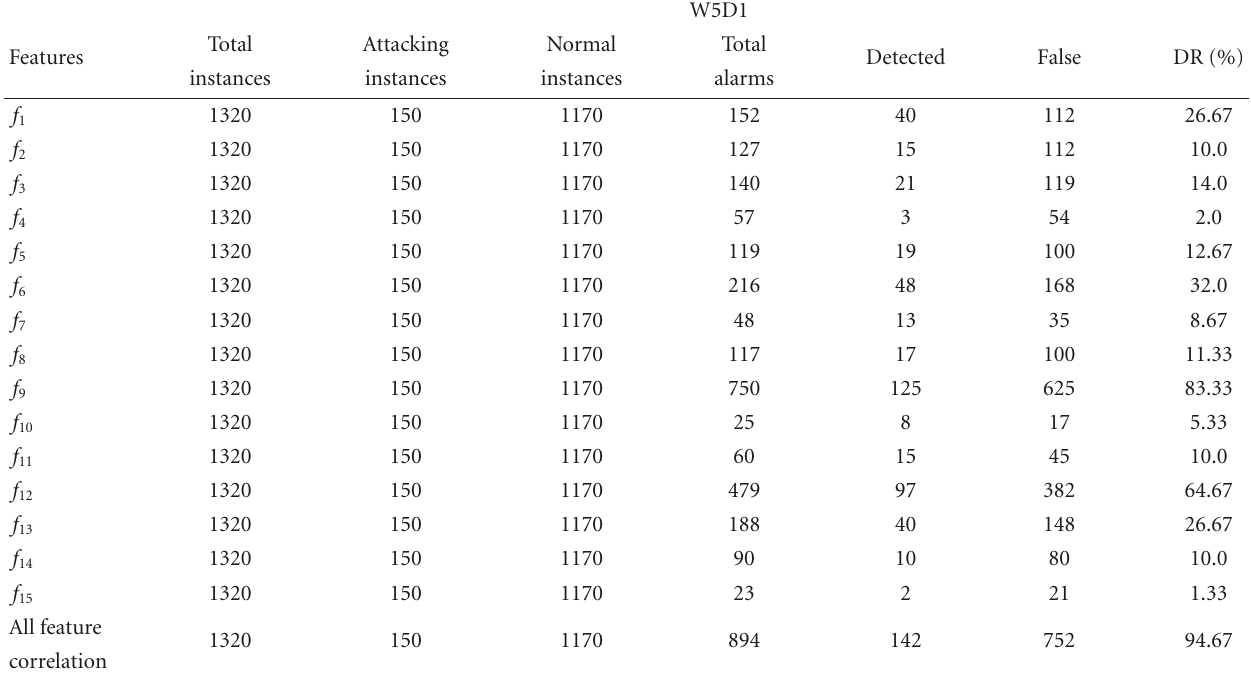
Table 6: Number of attack instances detected for each feature and all features correlation for